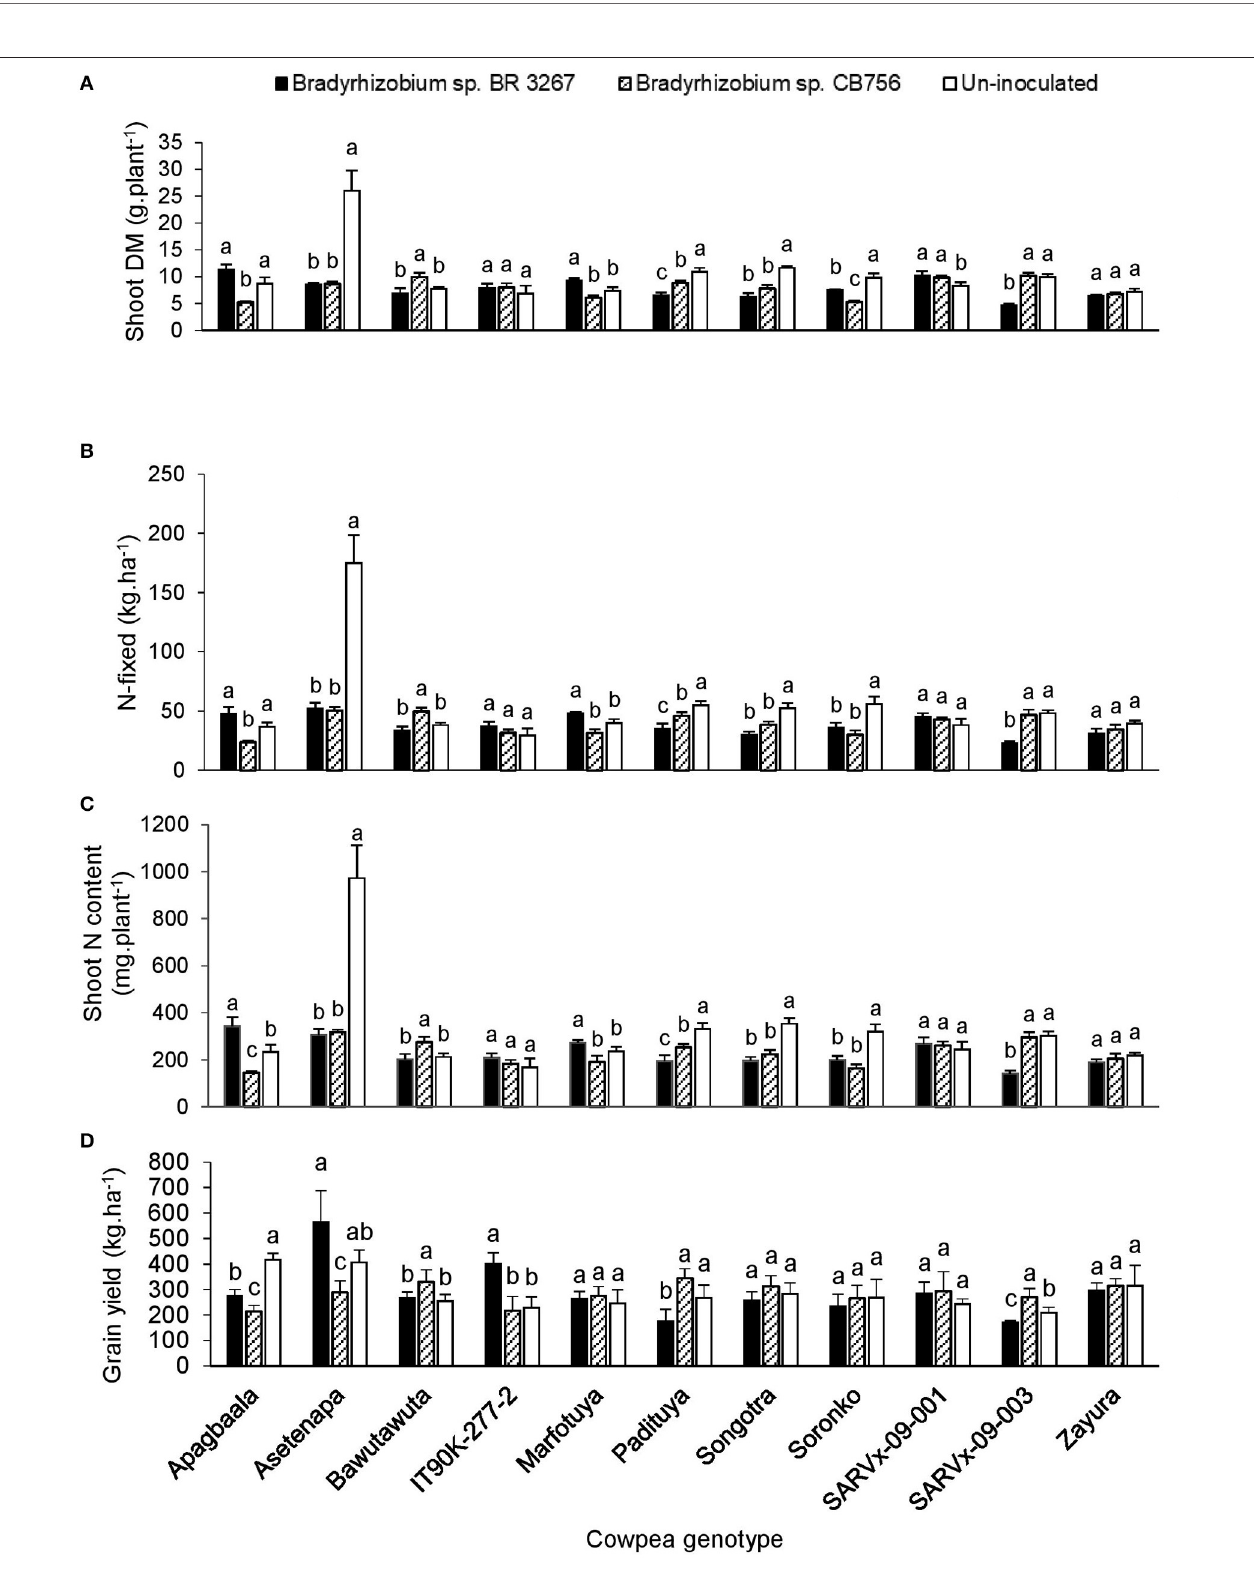
FIGURE 1 | The interactive effect of genotype x inoculation on (A) shoot dry matter, (B) N-fixed, (C) N content, and (D) grain yield of 11 cowpea genotypes planted in Nyankpala in 2013. For each genotype, bars with dissimilar letters are significantly different at p ≤ 0.05. Error bars represent standard errors.